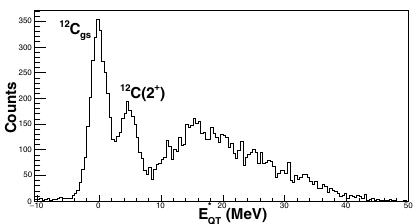
Figure 1. QT excitation energy as calculated in eq. (3).